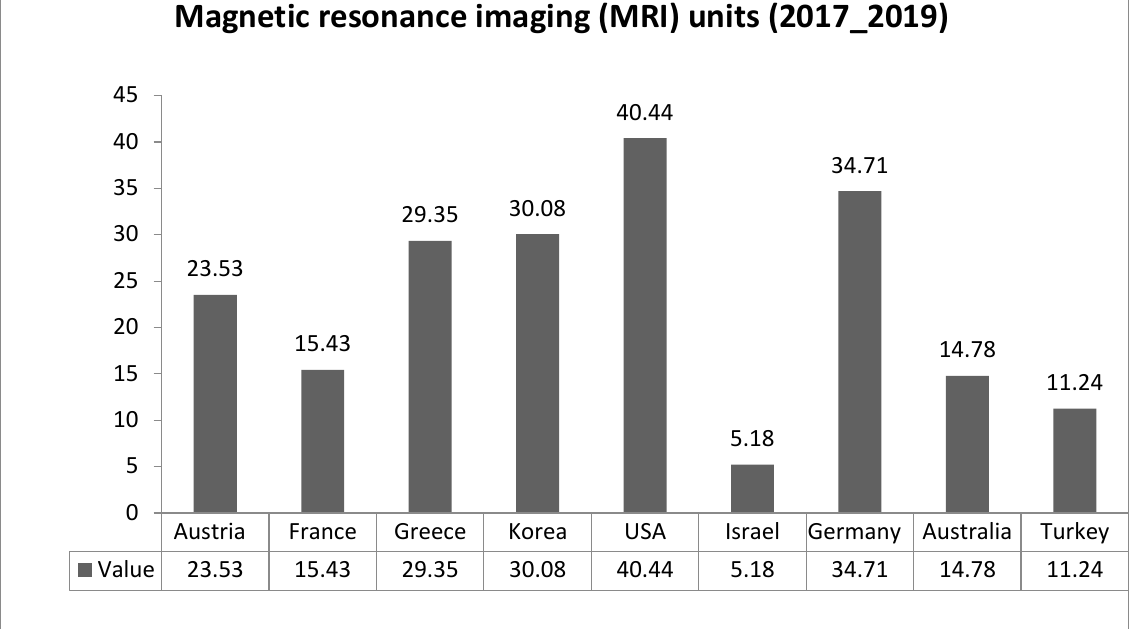
Figure 2. Distribution of Magnetic resonance imaging (MRI) units in the selected countries (Total/per million population).